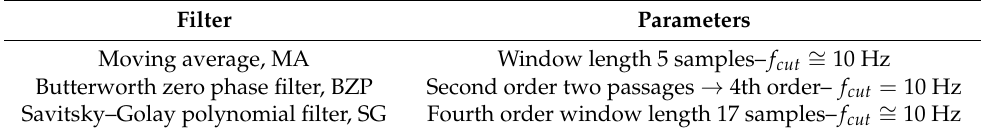
Table 2. Low pass filters